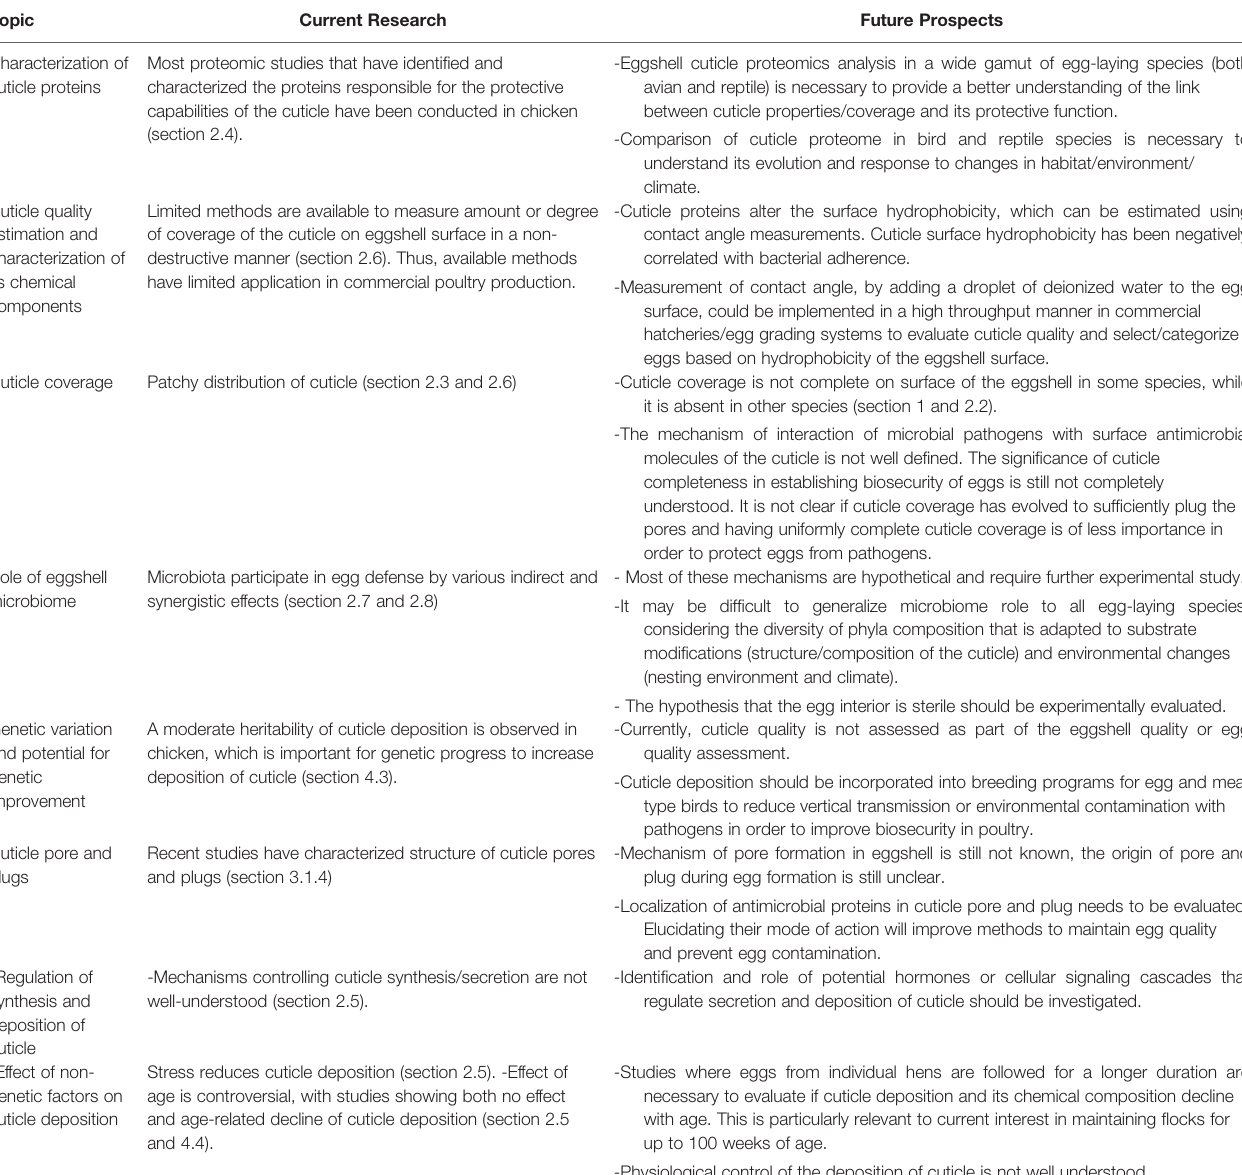
TABLE 2 | Challenges and proposed new strategies to understand innate immune functions of the eggshell